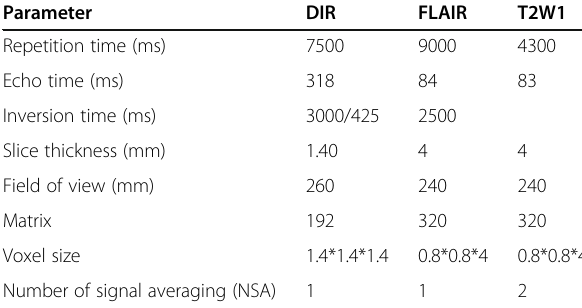
Table 1 MRI sequence parameters for multiple